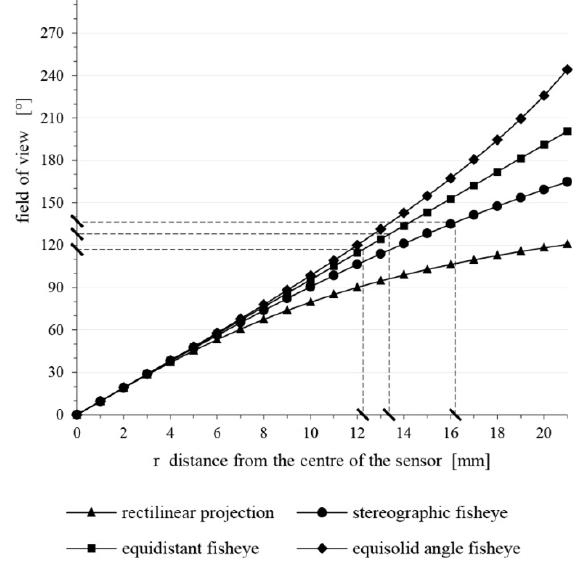
Figure 5 . Field of view that can be reached with different optical projection. The simulation is done using the same parameters described in Figure